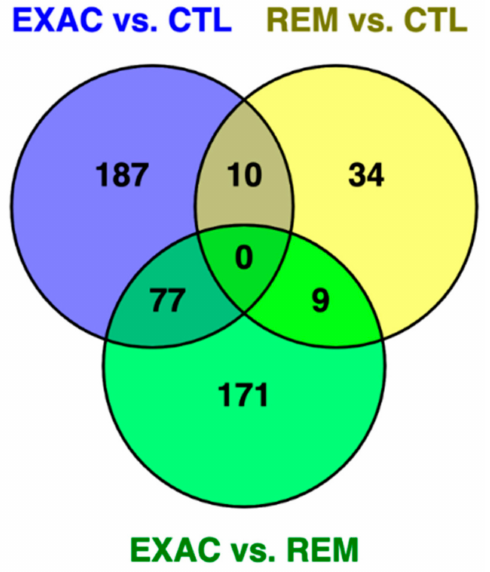
Figure 3. Venn diagram of the three sets of di ff erentially expressed genes between the three comparisons: ‘exacerbation (EXAC) vs. controls (CTL)’, ‘remission (REM) vs. controls’, and ‘exacerbation vs. remission’. The three overlapping sets shared between two contrasts varied from 9 to 77 genes (Supplementary Table